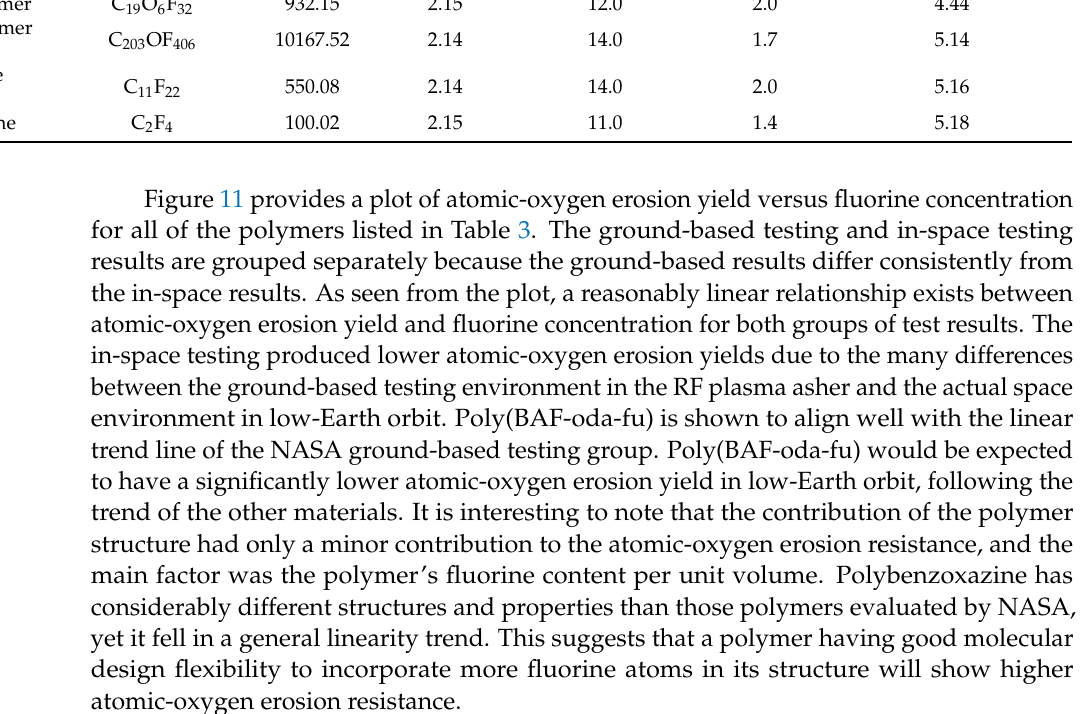
Table 3. Physical Properties, Atomic-Oxygen Erosion Yields, and Estimated Fluorine Concentration for poly(BAF-oda-fu) and Select Fluorinated Polymers Previously Tested by NASA.